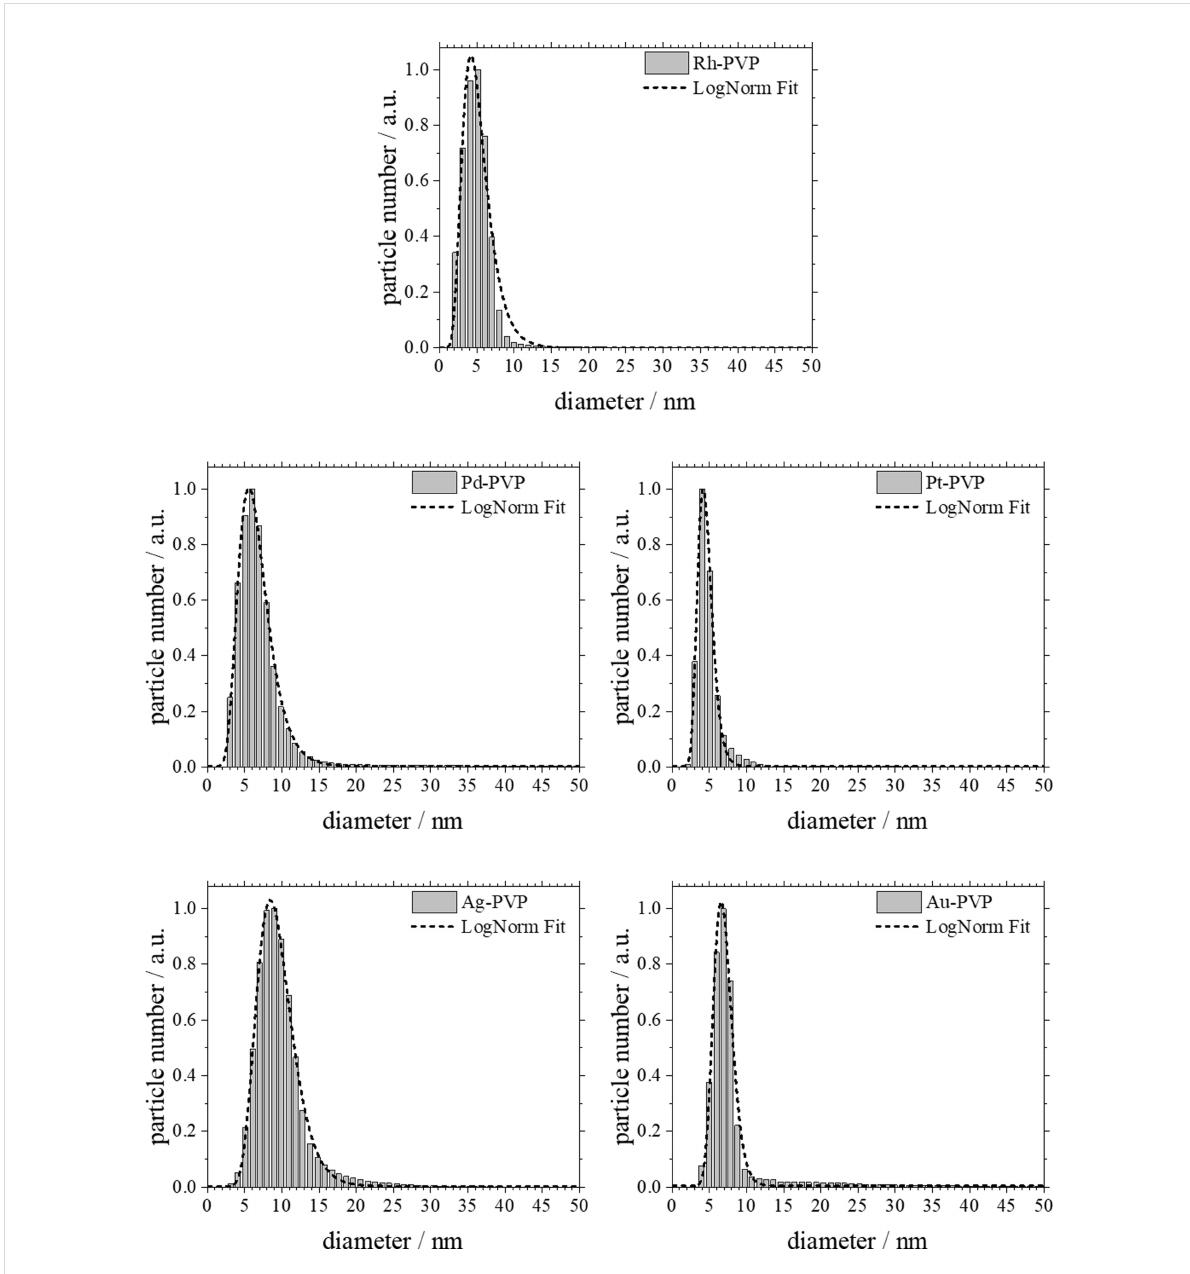
Figure 2: Particle size distributions of noble metal nanoparticles determined by analytical disc centrifugation (disc centrifugal sedimentation; DCS). All data are given as size by number and are normalized for better comparison.